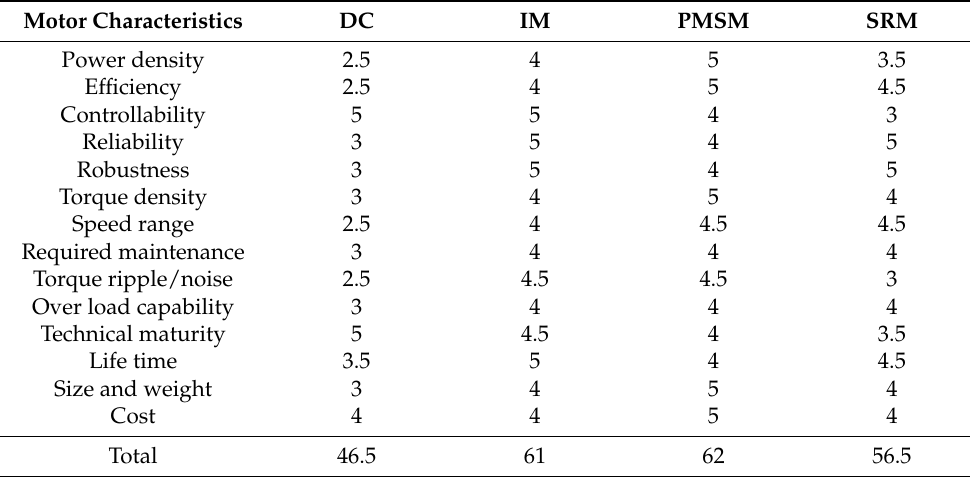
Table 2. Traction motor performance evaluation [2,5,9]. Motor